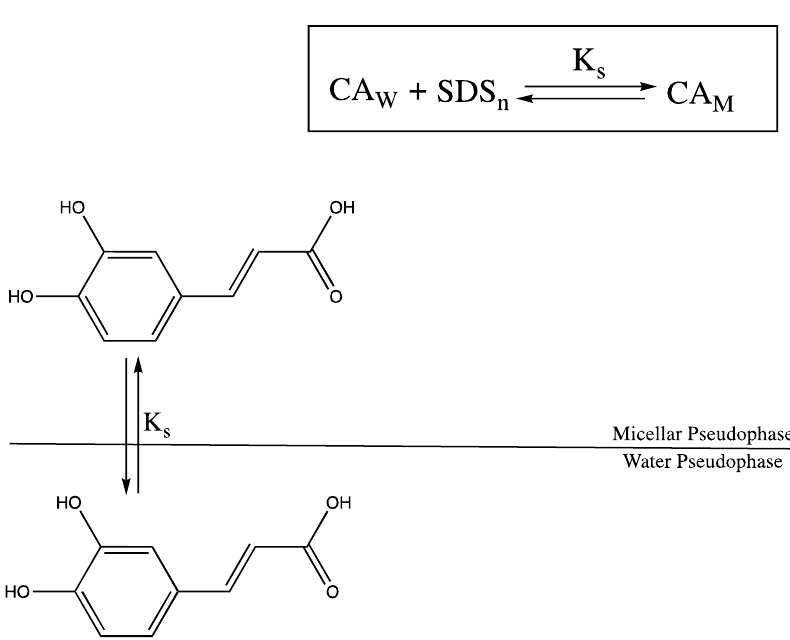
Scheme 2. Proposed mechanism for CA binding to SDS micelles.